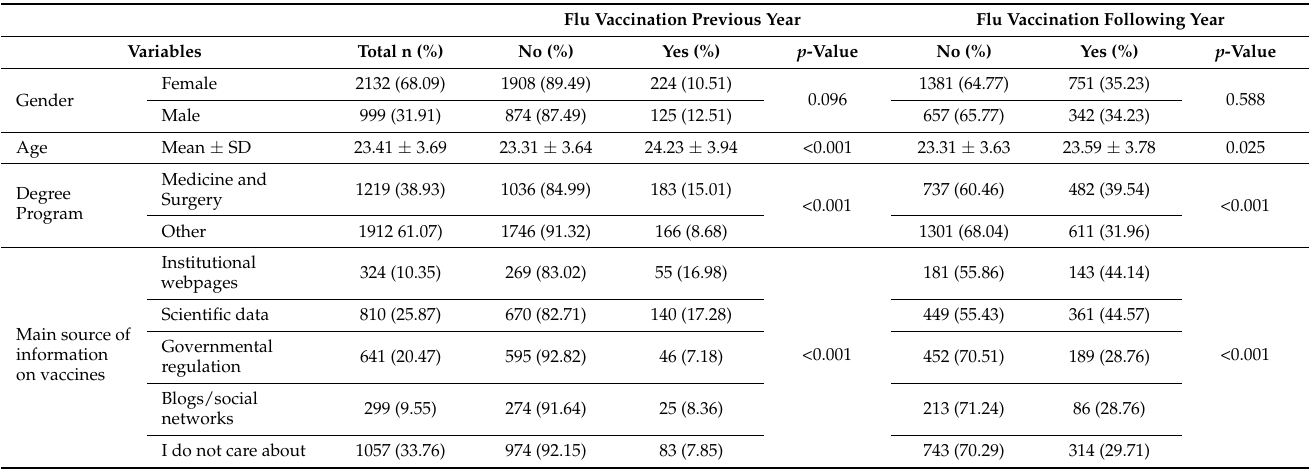
Table 1. Descriptive characteristics of the sample and bivariate associations. Used Pearson’s Chi- square